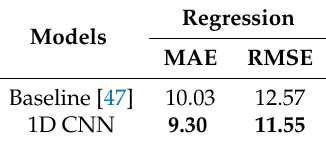
Table 4. Results of experiments on the Audio-Visual Depressive Language Corpus (AViD-Corpus) dataset.